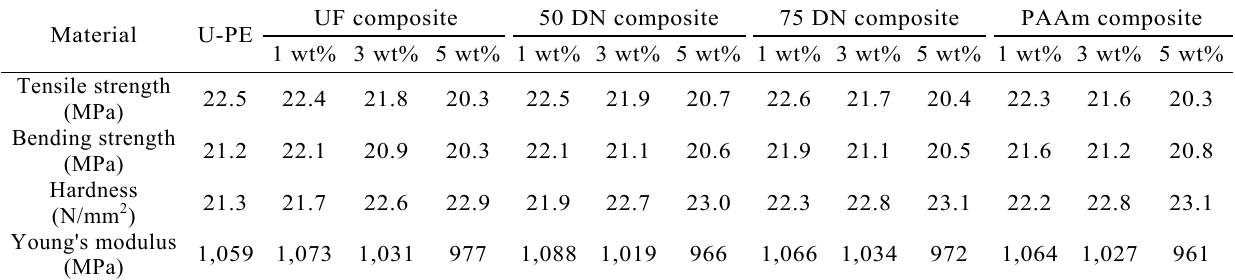
Table 2 Mechanical properties of UHMWPE and composites with soaking for seven days. UF composite 50 DN composite 75 DN composite PAAm composite Material